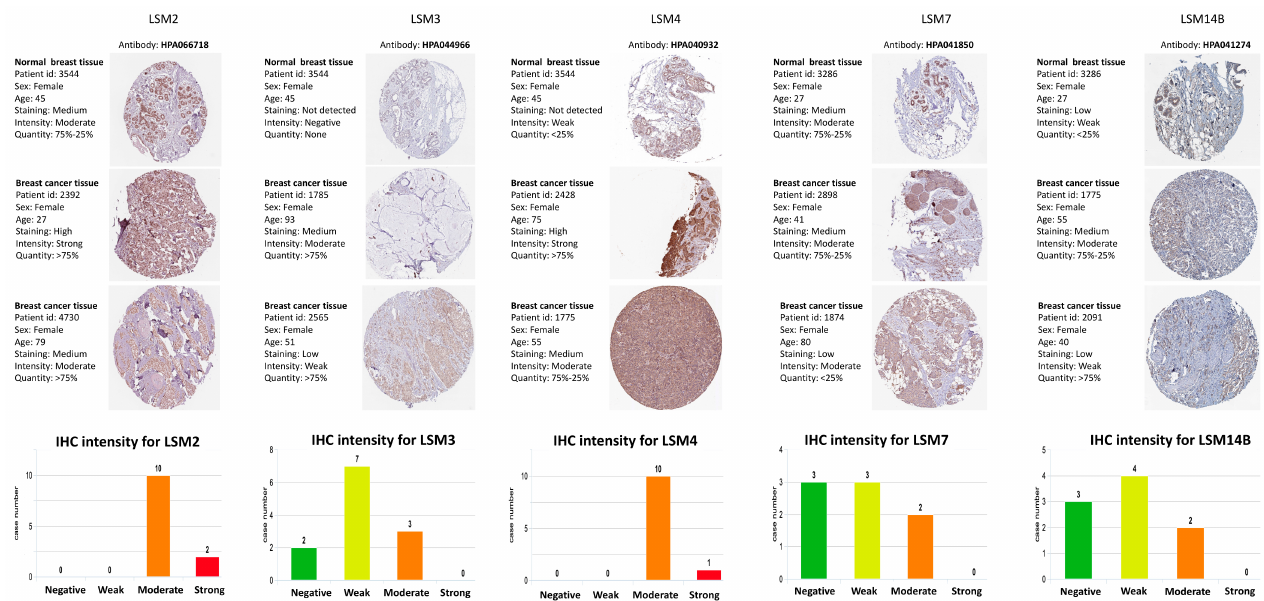
Figure 4. Representative IHC images of LSM2, LSM3, LSM4, LSM7, and LSM14b in breast cancer patients, which showed normal and tumor samples (Human Protein Atlas) and IHC intensities of these genes. Bar charts represent IHC staining intensities of LSM2 (12 patients), LSM3 (12 patients), LSM4 (11 patients), LSM7 (8 patients), and LSM14B (9 patients). All IHC images and patient information were obtained from the Human Protein